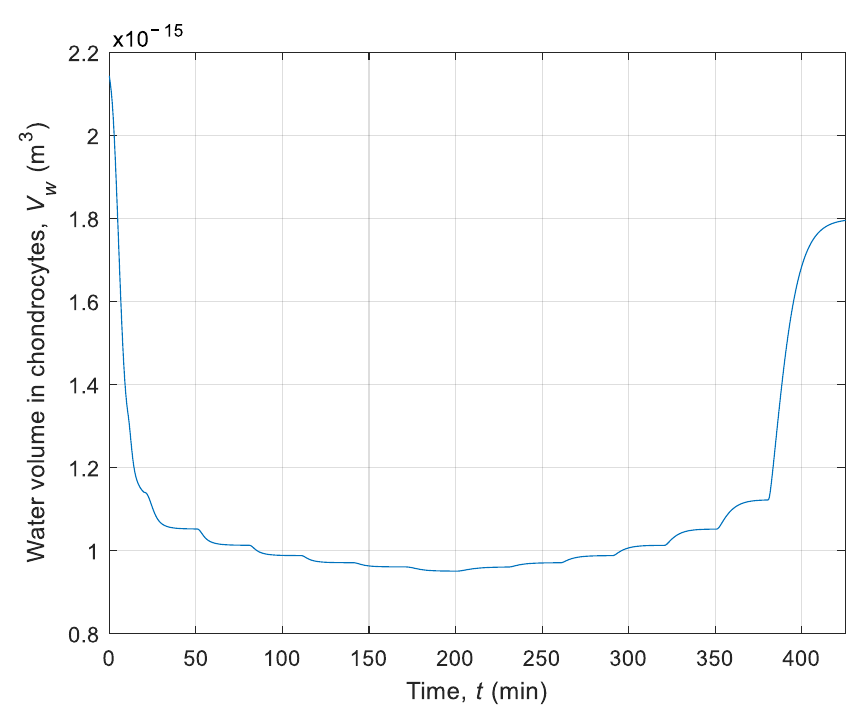
Figure 7. History of water volume in chondrocytes during cryopreservation.